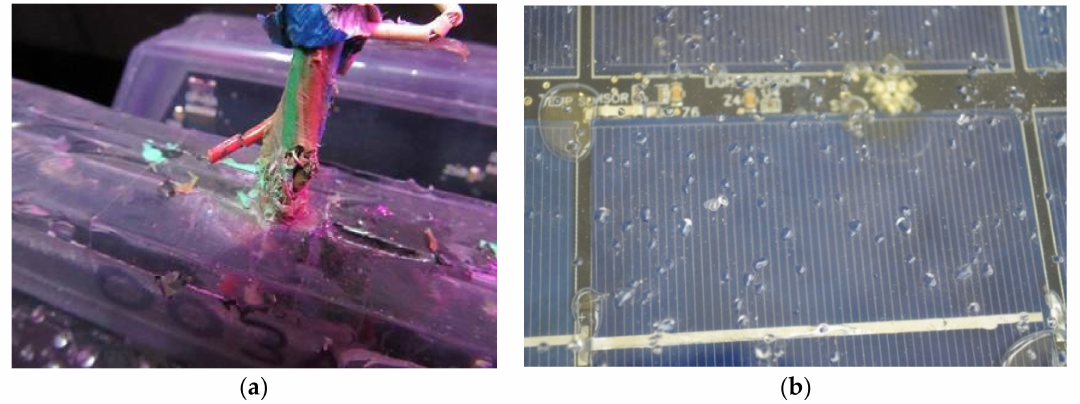
Figure 8. ( a ) Photograph revealing cord damage on panel; ( b ) example panel variations due to manufacturing process (i.e., internal in-polymer “bubble” formation).